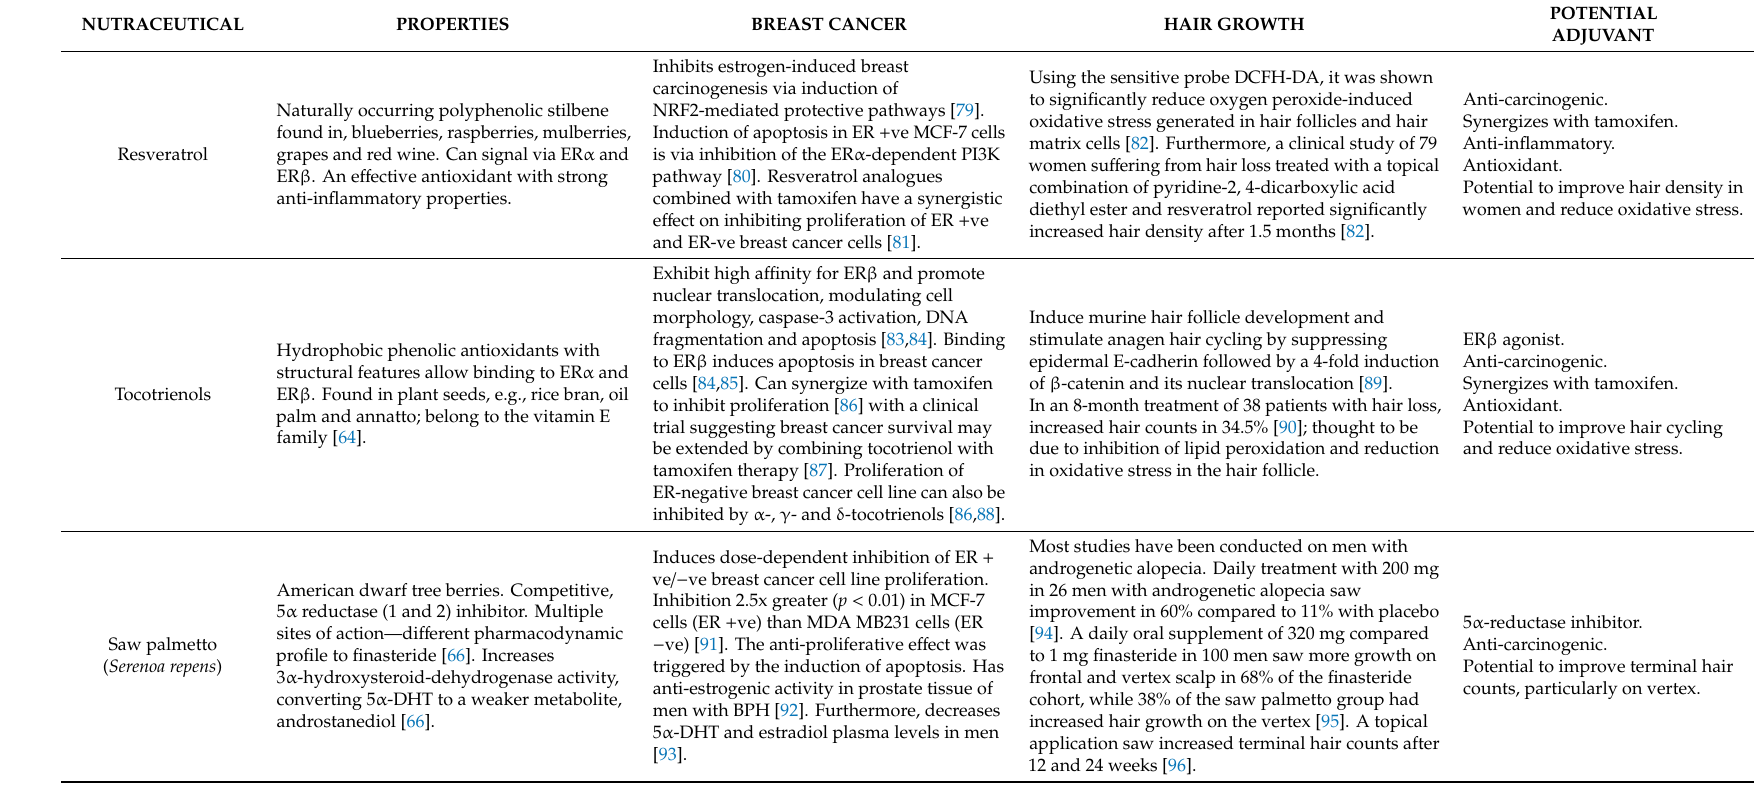
Table 1. A summary of the estrogenic and antioxidant properties of nutraceuticals that provide a basis for complementary and alternative medicine in both breast cancer and hair growth. Their protective and inhibitory e ff ects on breast cancer are summarized in addition to a potential role for the improvement of hair